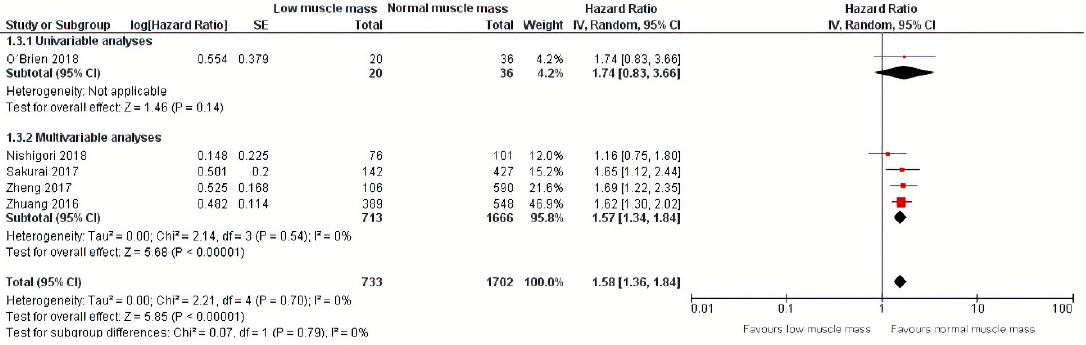
Figure 6. Forest plots of univariable and multivariable hazard ratios for disease-specific mortality for